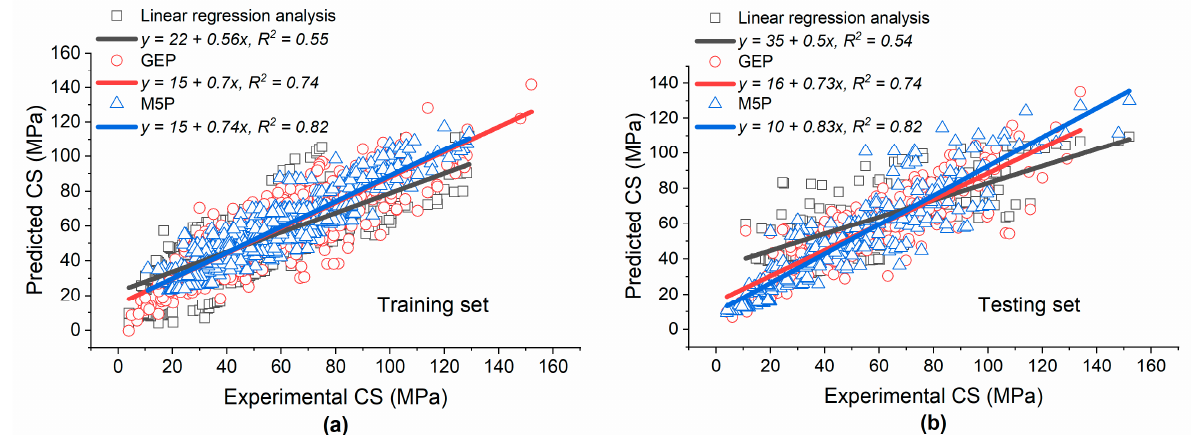
Table 4. Comparison of the different models developed for the CS database.